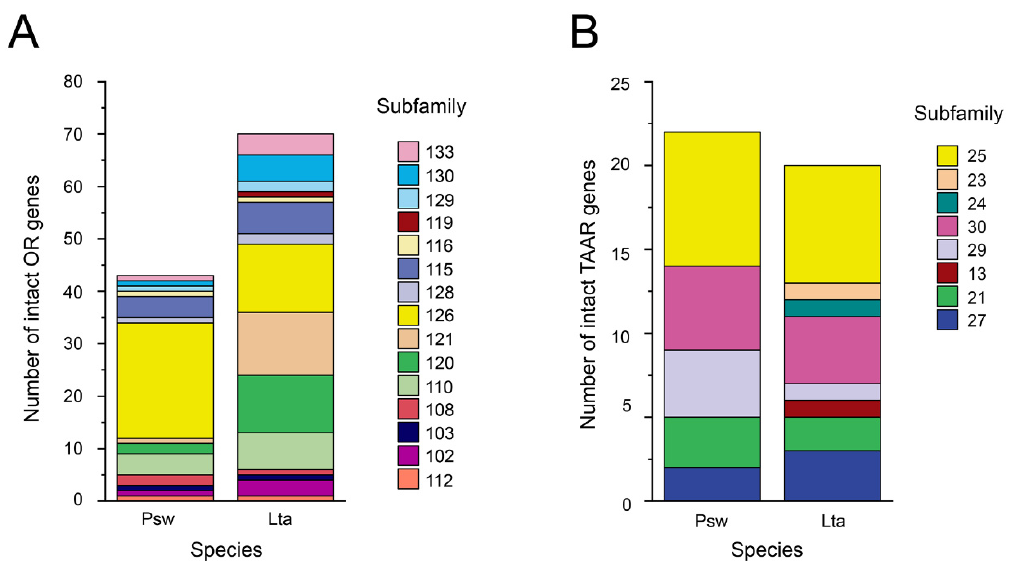
Figure 3. Comparison of OR ( A ) gene number and TAAR ( B ) gene number. The number of intact ORs and TAARs between the Mariana snailfish and Tanaka’s snailfish is shown by a stacked bar graph. Each of the subfamilies is indicated by a different color. Abbreviation of species names is as follows: Psw, Mariana snailfish; Lta, Tanaka’s snailfish.